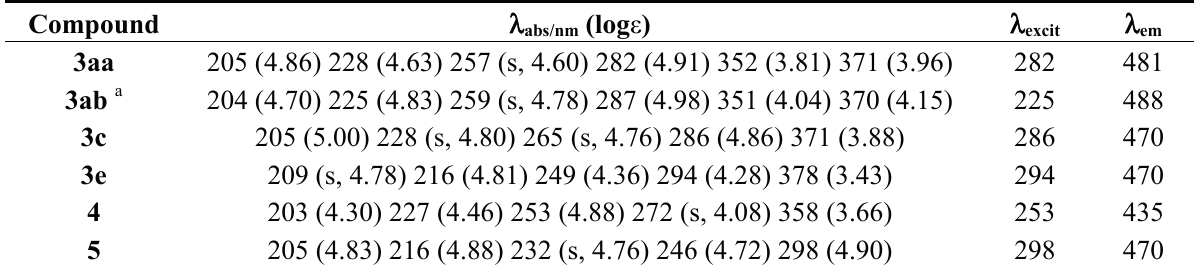
Table 2. UV absorption and emission spectral data of 3 , 4 and 5